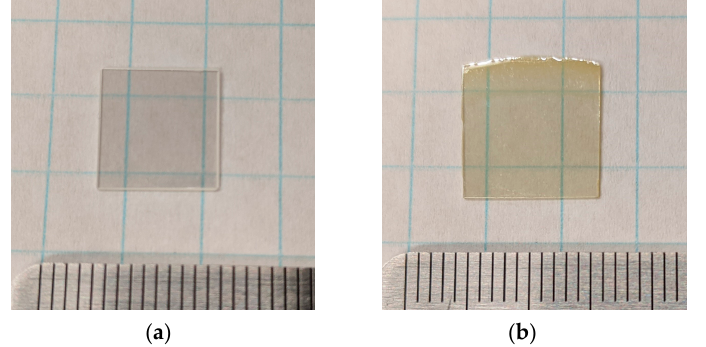
Figure 4. The LiNbO 3 single crystal control sample ( a ) and prepared PMN-PT sample ( b ) arranged with millimeter scales for reference. with millimeter scales for